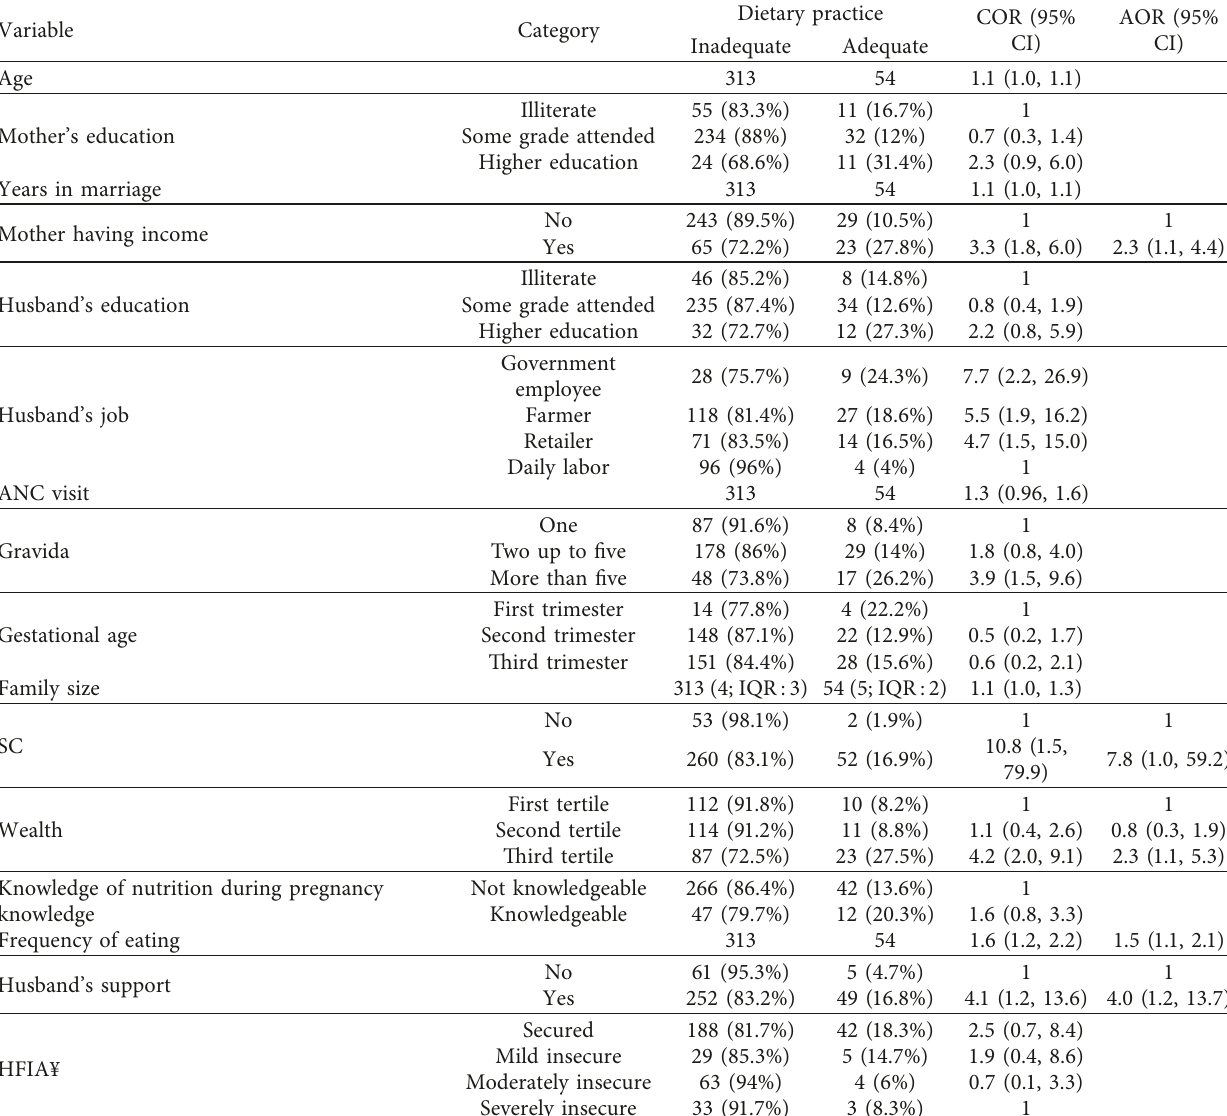
Table 3: Factors associated with dietary diversity practice of pregnant mothers in Arba Minch Zuria district, South West-Ethiopia,